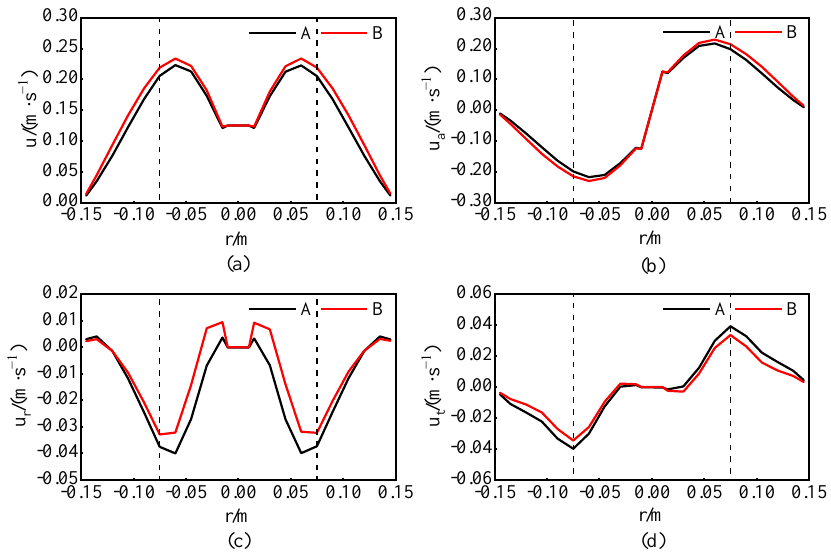
Figure 16. Velocity distribution at the axial position y = 120 mm when the medium is glycerol and Re = 55.5. The distance between the two curves is the nominal diameter of the blade. ( a ) Total speed comparison; ( b ) Axial velocity comparison; ( c ) Radial velocity comparison; ( d )Tangential velocity comparison.